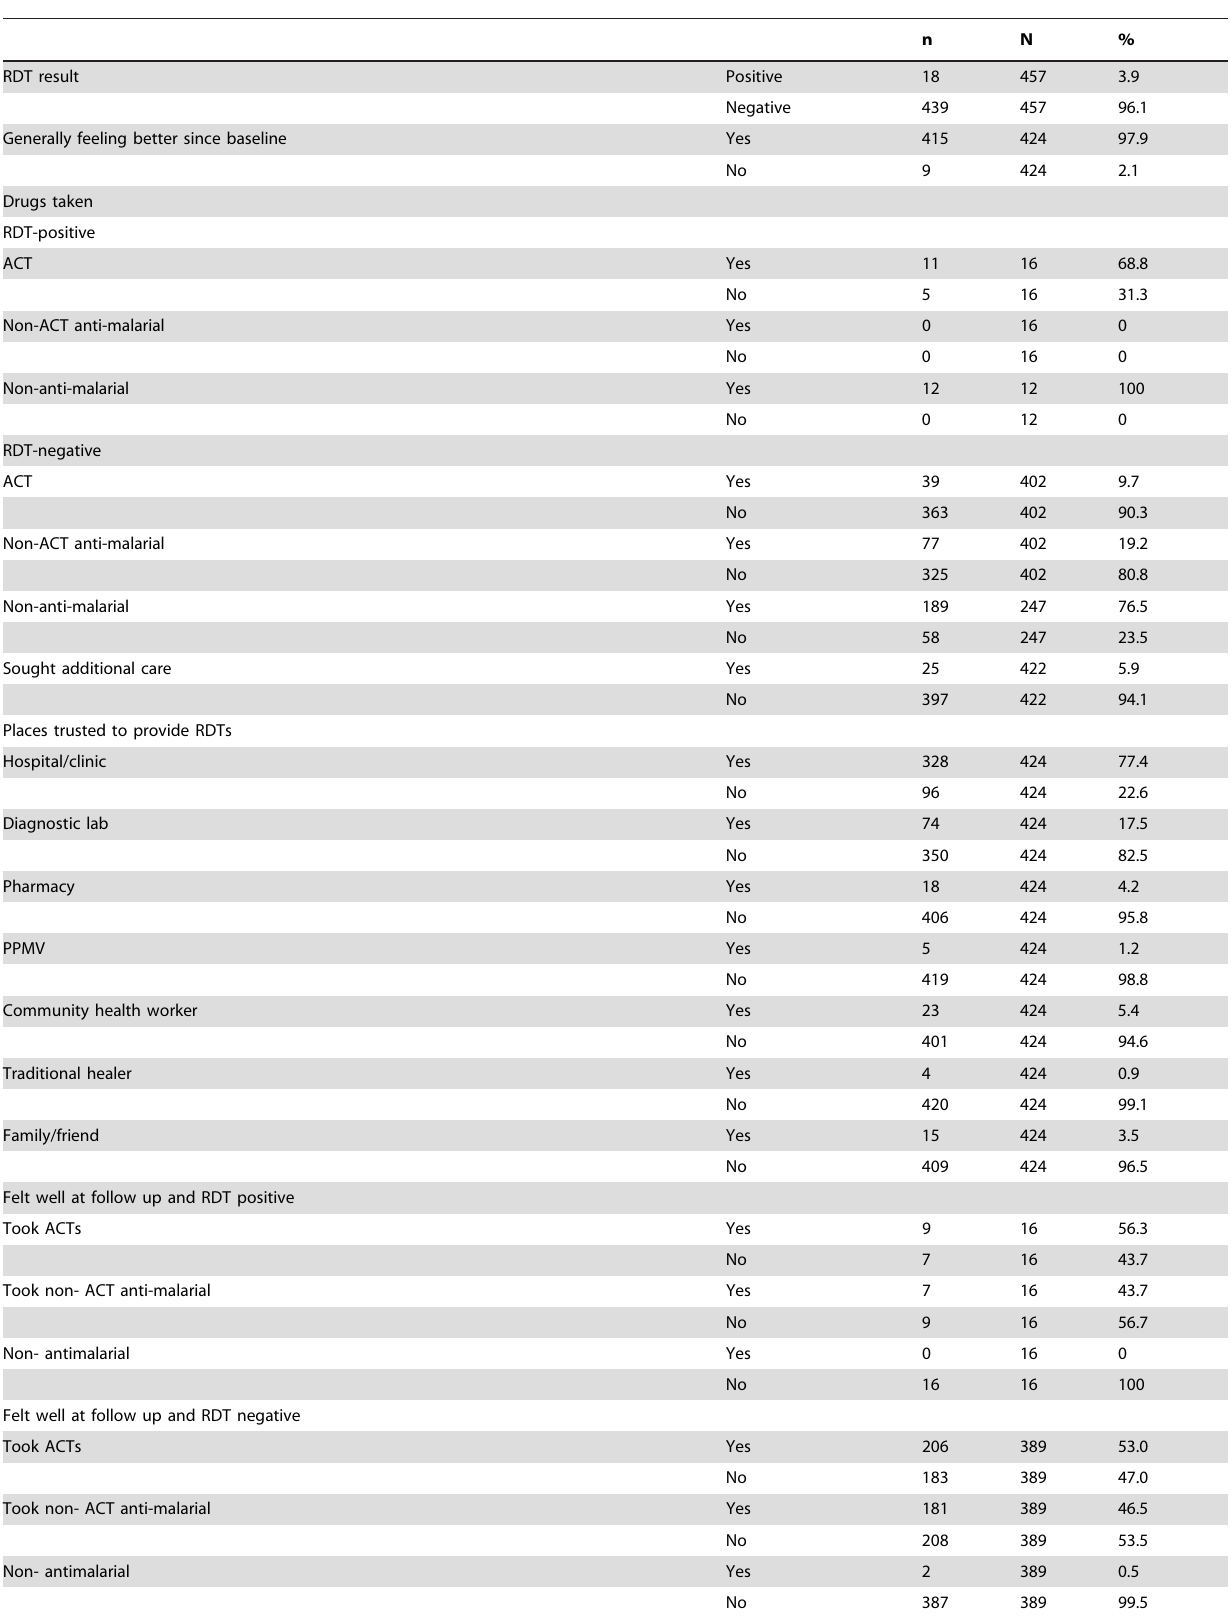
Table 5. RDT result and self-reported drug